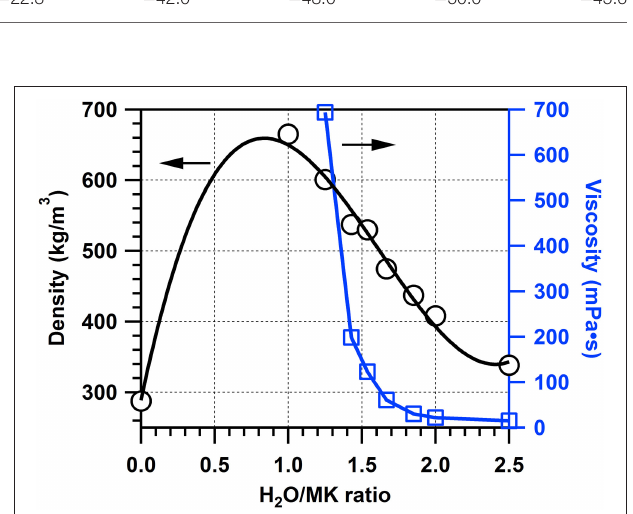
FIGURE 4 | Density and viscosity of MK-water slurry under various H 2 O/MK